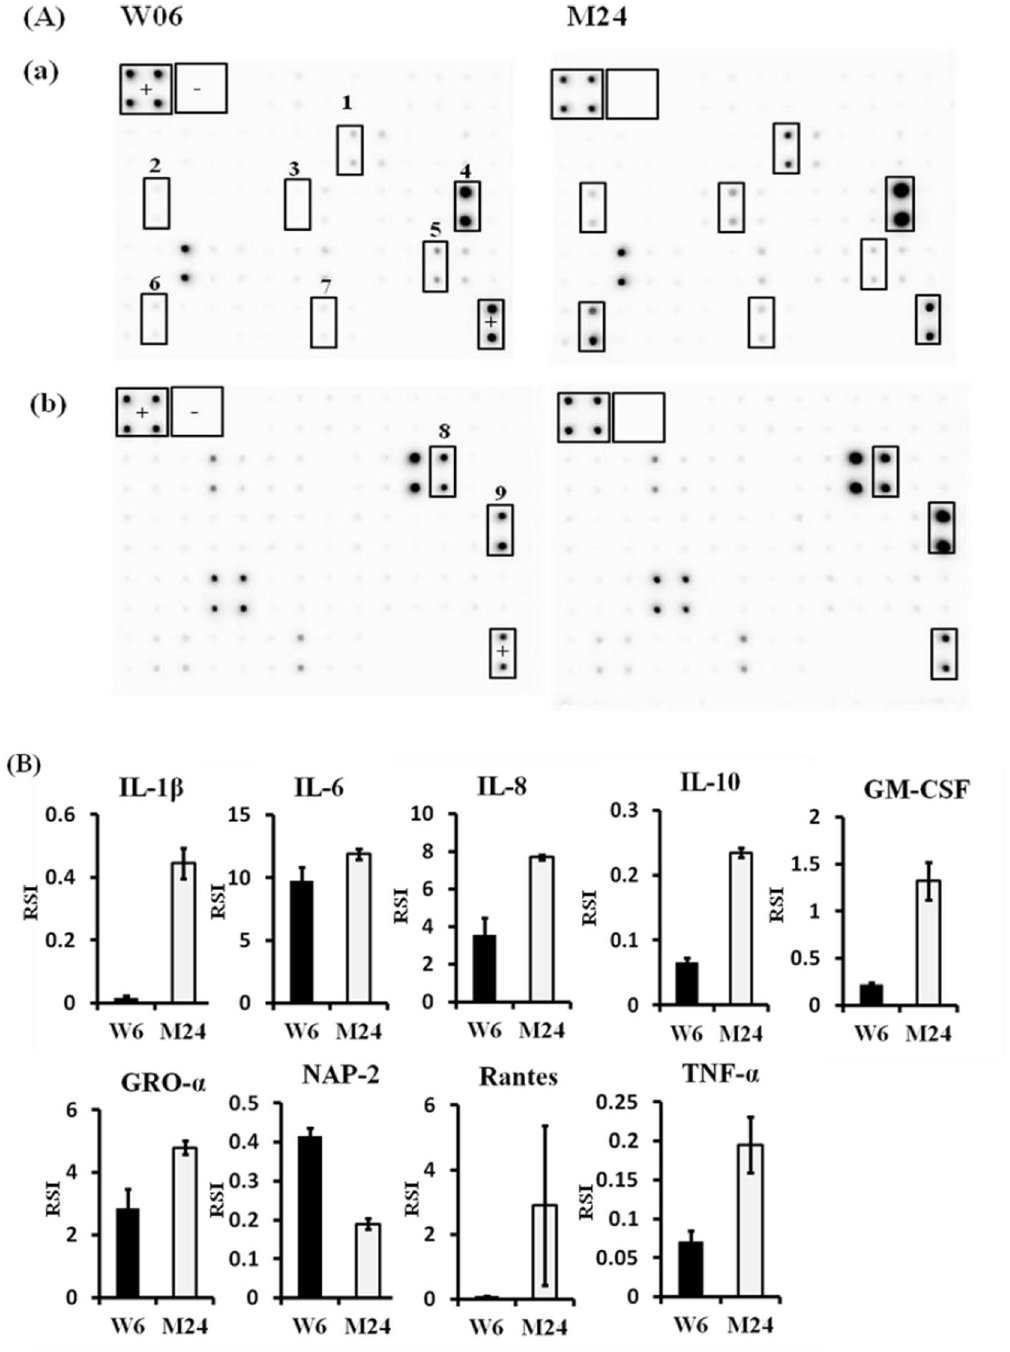
Figure 2. Cytokine arrays reveal differences in cytokine/chemokine expression patterns of MDM infected with M.tuberculosis W06 or M24 strains. Human MDM were infected with M. tuberculosis W06 or M24 Beijing strains for 72 h, after which the cell culture supernatants were collected and analyzed for cytokine/chemokine content using a RayBio human cytokine antibody array C series 1000 (a and b). The detection signals were captured with X-ray films (A). The signals on the membranes were quantified by densitometry (B). + , positive control spots; -, negative control spots; 1, GM-CSF; 2, IL-10; 3, IL-1 b ; 4, IL-6; 5, NAP-2; 6, Rantes; 7, TNF- a ; 8, GRO- a ; 9, IL-8.